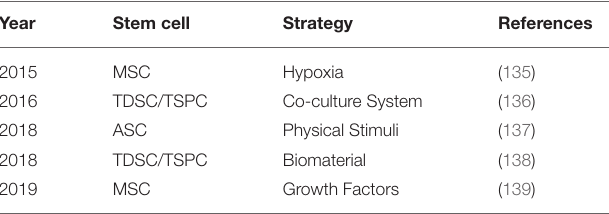
TABLE 2 | Research’s on tendon stem cell therapy in recent